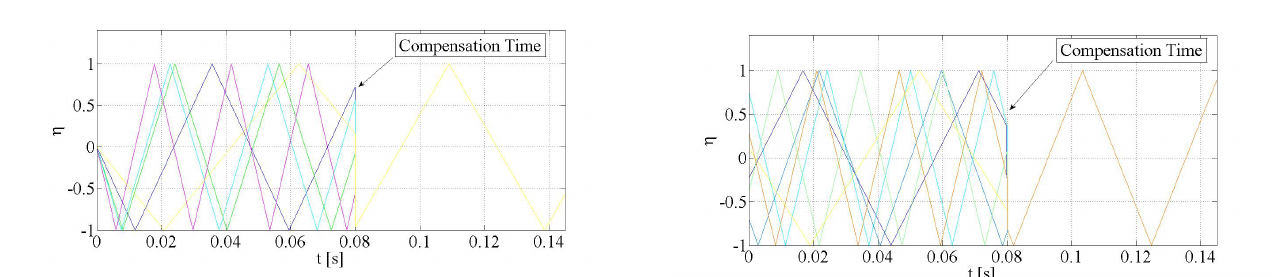
technology corresponds to realization of a Local Area Network (LAN) resulting low impact, because of the well-known and inexpensive